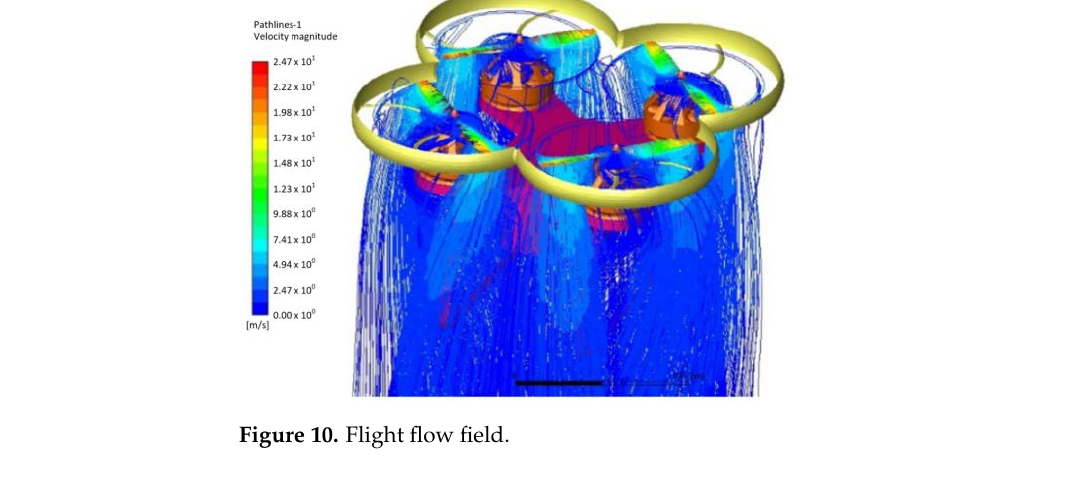
Figure 11. Stress cloud map ( a ) and deformation cloud map ( b ) of rotor under lift and self-weight.